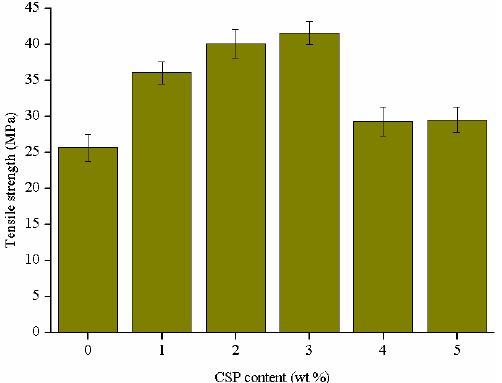
Figure 7. Tensile strength of the epoxy/amino-terminated hyperbranched polymer (ATHBP) thermosets modified with different contents of CSPs.